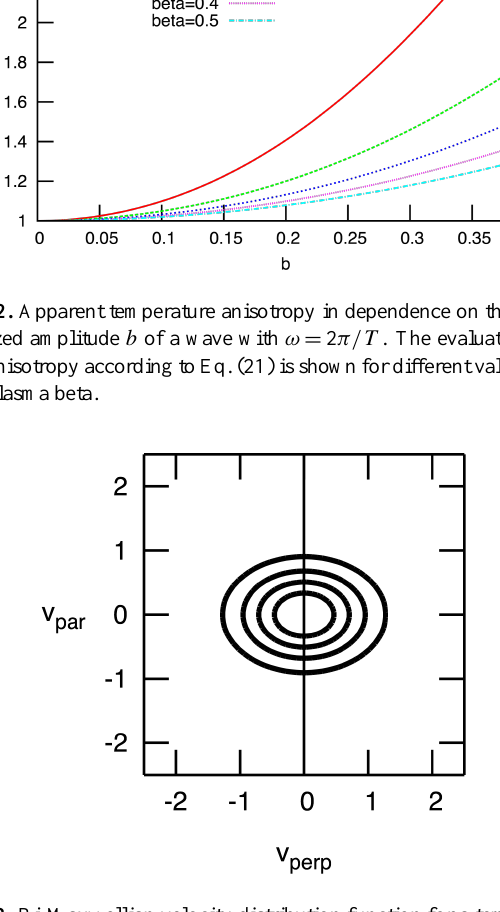
Fig. 3. Bi-Maxwellian velocity distribution function for a tempera- ture anisotropy of